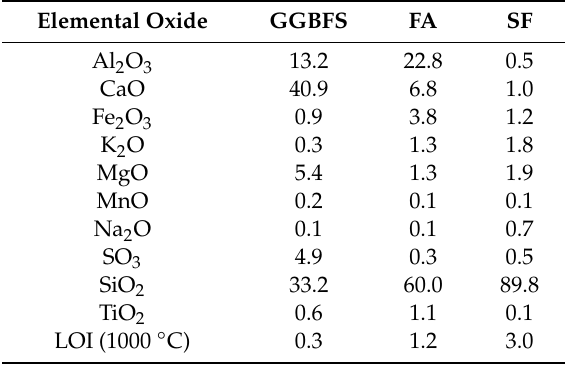
Table 1. Bulk oxide composition (wt %) of FA, GGBFS and SF used in this study with the LOI at 1000 ◦ C from XRF